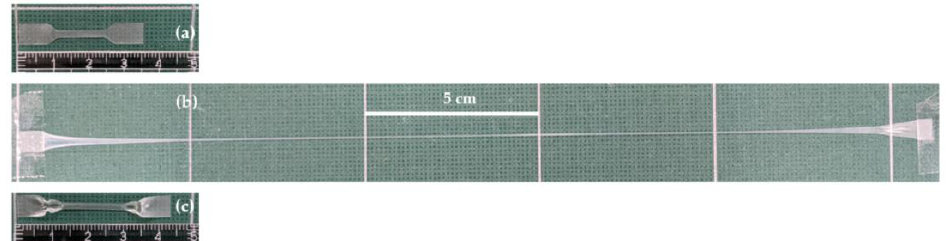
Figure 8. Stress – strain curve of Samples 1 (3M2MP 5.5 mol%), 2 (10.1 mol%), 3 (34.2 mol%), 4 (53.9 mol%), 5 (54.8 mol%), 6 (10.7 mol%), and 7 (100 mol%).